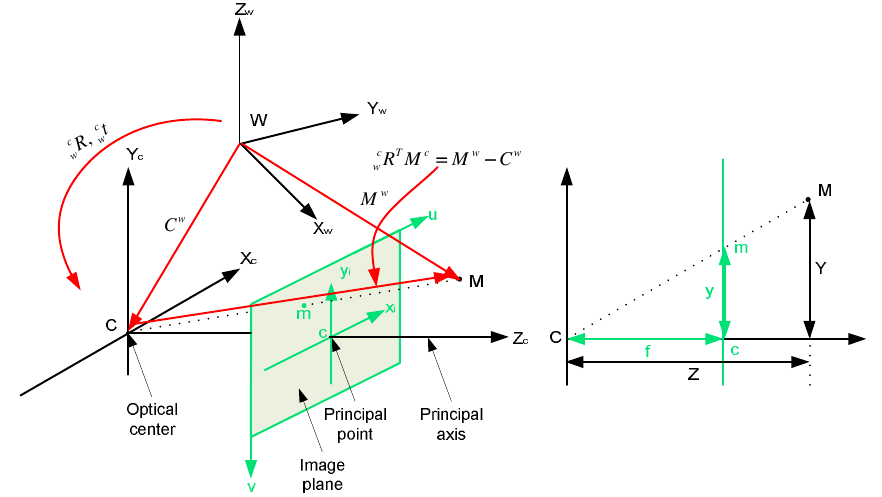
Figure 3. left : the relationship between the camera and image coordinates and between the camera and world coordinates; right : side view of the left figure is used to derive the relationship between the camera and image coordinates based on the principle of